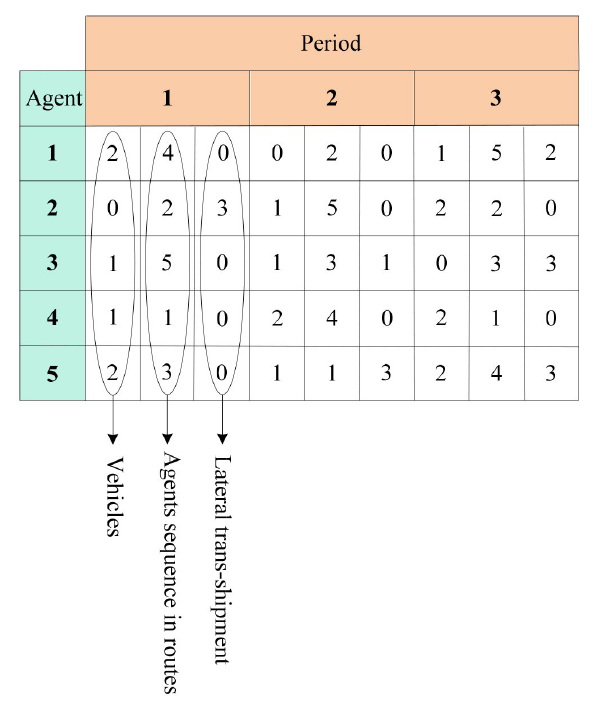
Figure 3. Chromosome representation